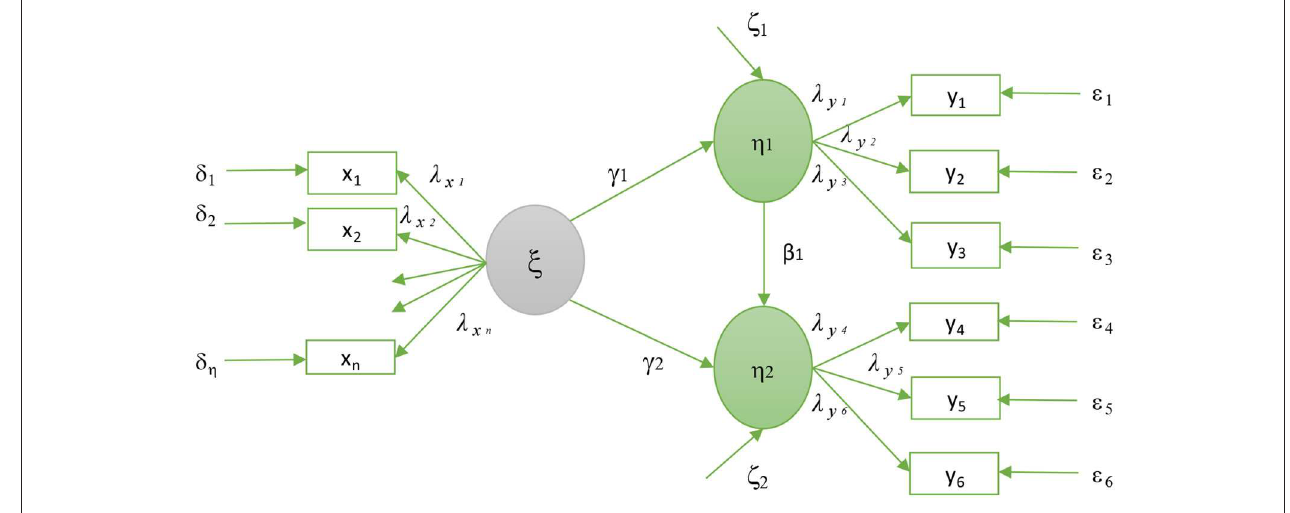
FIGURE 3 | Structural Equation Modeling sample model.